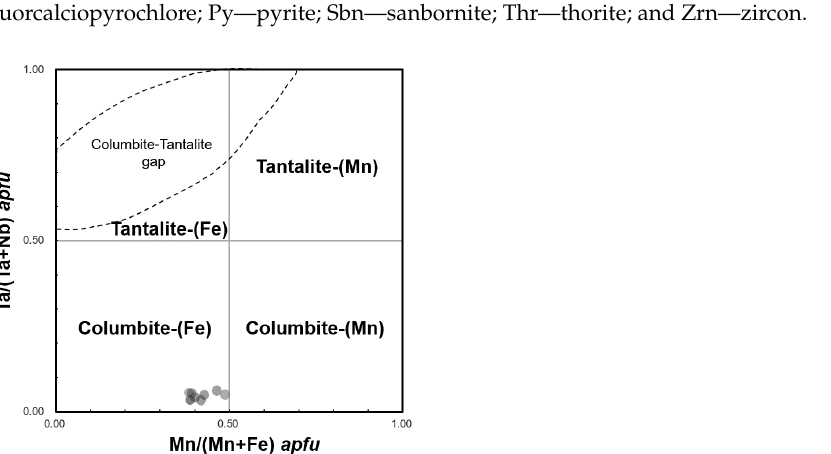
Figure 6. Compositional diagrams (atomic proportion) for the columbite-(Fe) from the Baicao and Xiaoheiqing deposits.